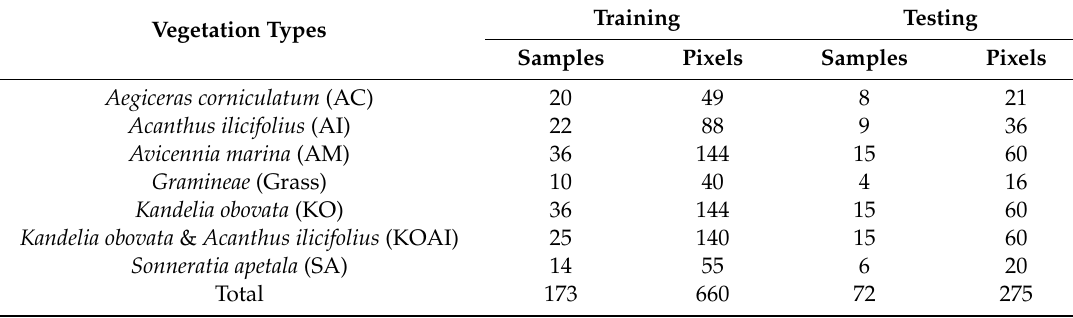
Table 2. Vegetation types and their training and testing sample for image classification.